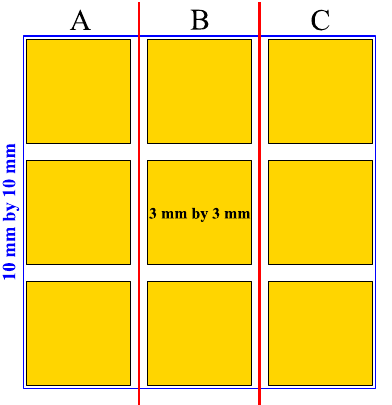
Figure 1. The schematic diagram of samples used in the carried out experiments.